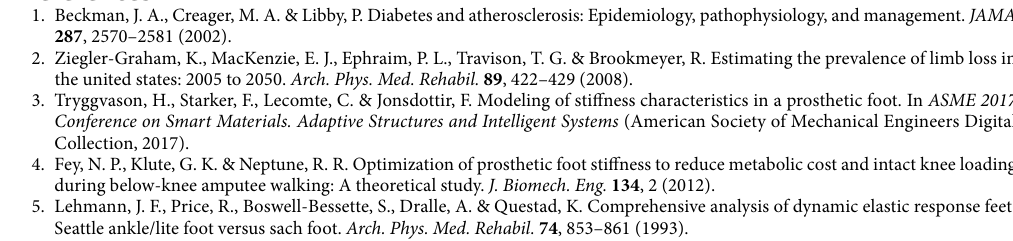
of the human foot not exceeding the yield strength of the onyx. The simulation conditions used for toe-off was validated by comparing simulation result with human data. Consequently, the simulation result showed good agreement with human walking data in the GRF versus COP graph and ankle kinematics.